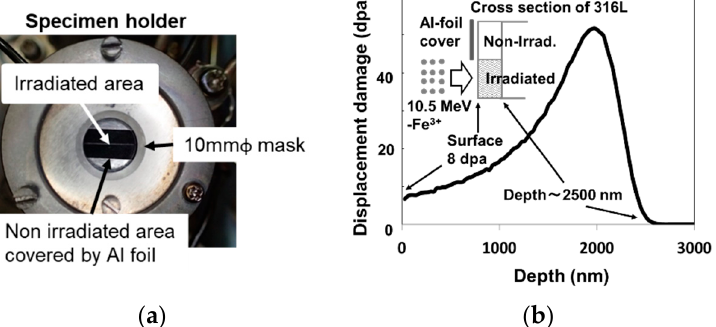
Figure 1. ( a ) Irradiation specimen holder and ( b ) depth distribution of displacement damage of ion irradiation. The experimental dpa was determined based on the depth distribution.